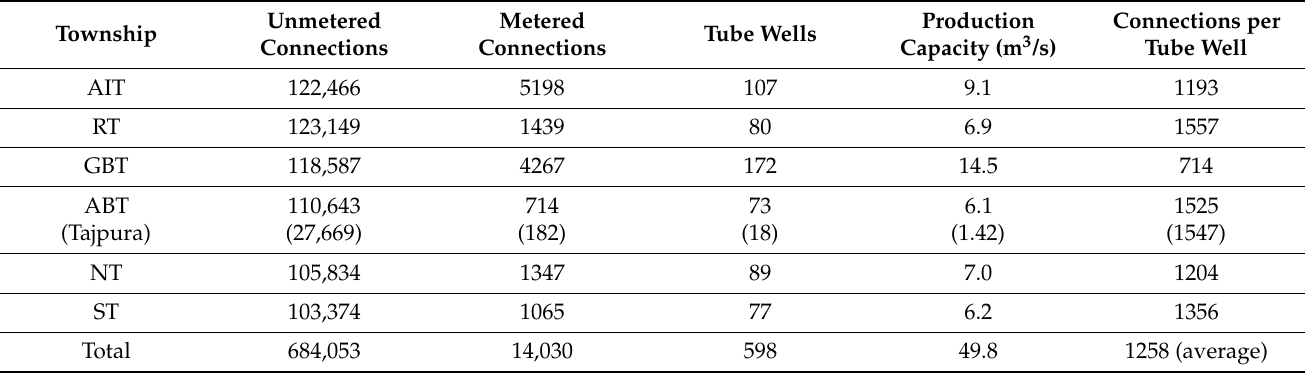
Table 2. Customer connections, tube wells, and production capacity in the six